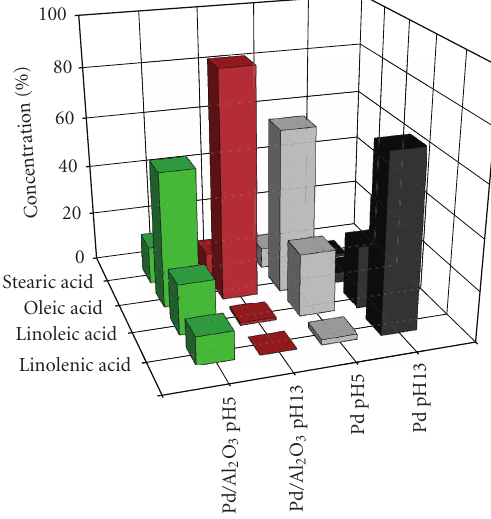
Figure 2: Distribution of products of the ECH of linolenic acid with di ff erent catalysts after passage of 38 C · mmol − 1 .